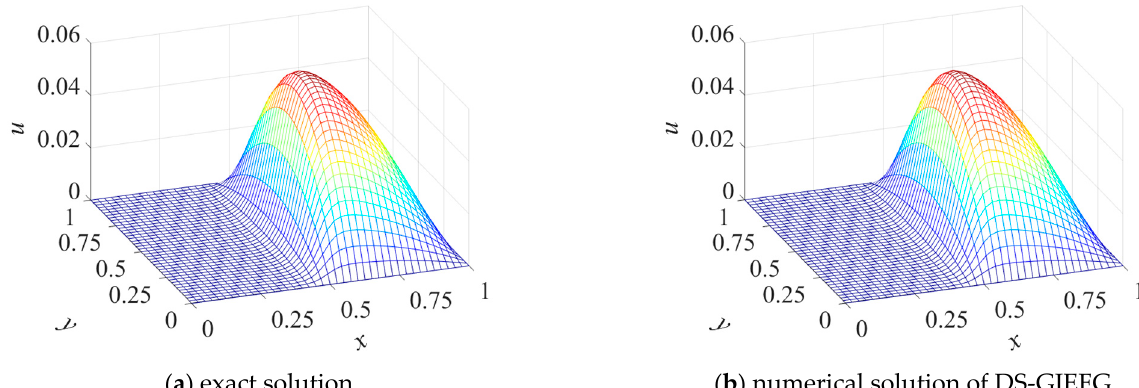
Figure 11. The exact and numerical solutions of the DS-GIEFG method with 51 × 51 regular nodes.